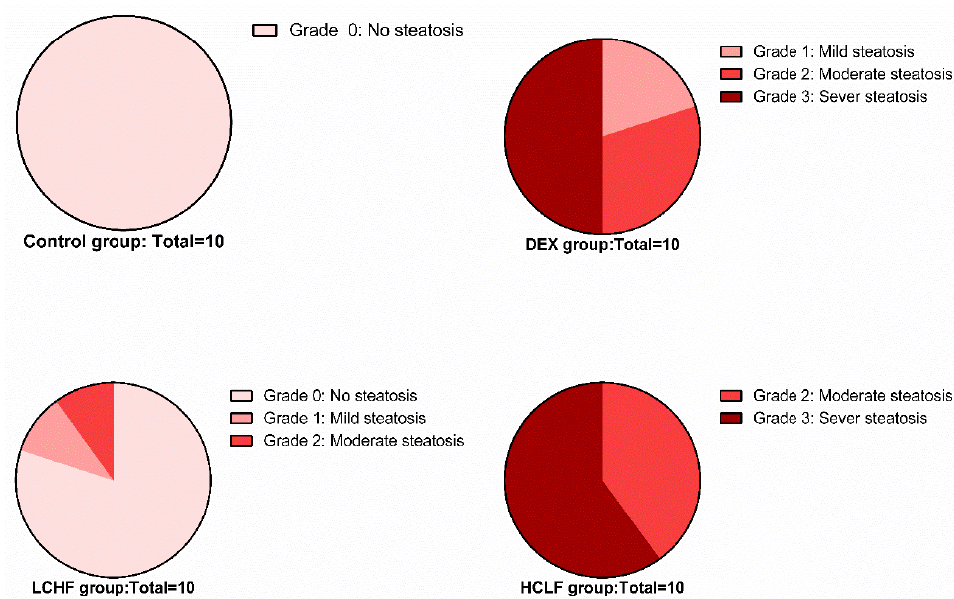
Figure 3. Pie chart shows the degree of steatosis in the control, DEX, DEX + LCHF, and DEX + HCLF groups. DEX: rats treated with dexamethasone to induce metabolic syndrome; DEX + LCHF: rats treated with dexamethasone to induce metabolic syndrome and fed on low-carbohydrate high-fat diet; DEX + HCLF: rats treated with dexamethasone to induce metabolic syndrome and fed on high-carbohydrate low-fat diet.